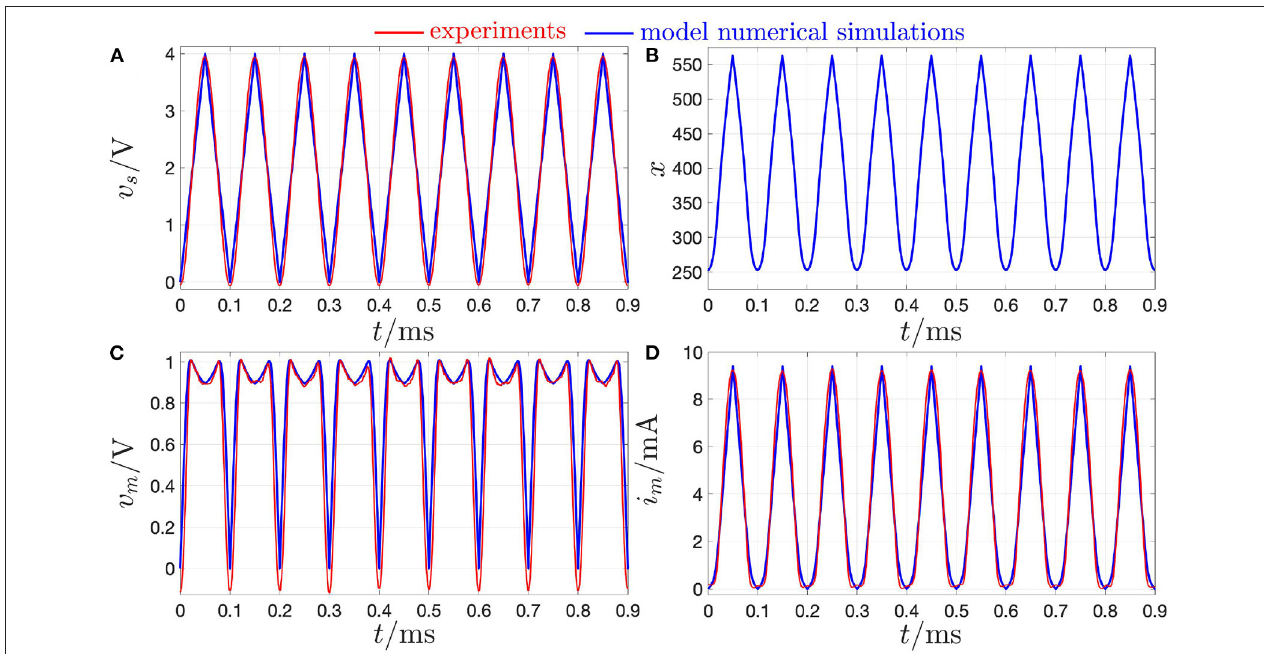
FIGURE 18 | Response of the NbO memristor to the application of a purely AC voltage stimulus across the one-port composed of the series connection between the v s same memristor and a linear resistor of resistance R s 330 (cid:127) , as shown in Figure 8a . (A) Strictly-positive triangular voltage waveform of amplitude 4V and ˆ = = period T 0.1ms. Here, the linear resistor limits the maximum current, which may ever flow through the NbO device, thus no compliance-related measure needs to = be taken to prevent the physical breakdown of the memristor as it switches on. (B) Time evolution of the memristor state upon the application of the periodic voltage waveform in (A) across the resistor-NbO device series one-port. (C) Memristor voltage over time under the AC voltage stimulus in (A) . (D) Time waveform of the memristor current in response to the AC input in (A) . The red and blue waveforms in (A,C,D) , respectively, extracted from experimental measurements, with the chamber hosting the device kept at an ambient temperature T amb of 20 ◦ C, and from a numerical simulation of the model DAE set (3) and (4), with state evolution and − memductance functions expressed by Equations (5) and (6), respectively, and under the initial condition x 0 253.15. Plotting the memristor current i m from (D) = against the memristor voltage v m from (C) , the resulting AC i m – v m locus, shown in Figure 19 in the green (yellow) color, as extracted through measurements (as derived from a numerical simulation of the model), matches rather well the threshold switch DC I m – V m locus, drawn in black in the same figure, despite the stimulus frequency is well beyond 0Hz. Given that the threshold switch behaves similarly as under DC excitation, the 10kHz AC input voltage in (A) may be